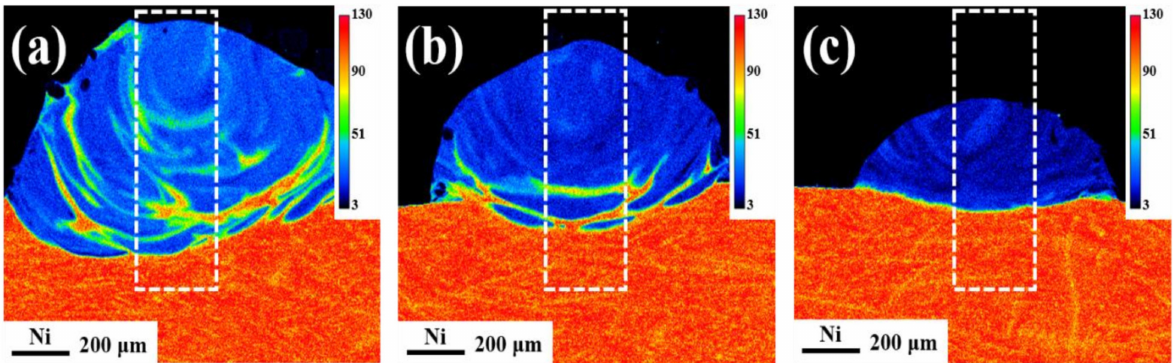
Figure 5. Ni segregation of Fe-Cr-Si single-line clads at various laser traverse speeds: ( a ) 12 mm/s, ( b ) 14 mm/s, and ( c ) 16